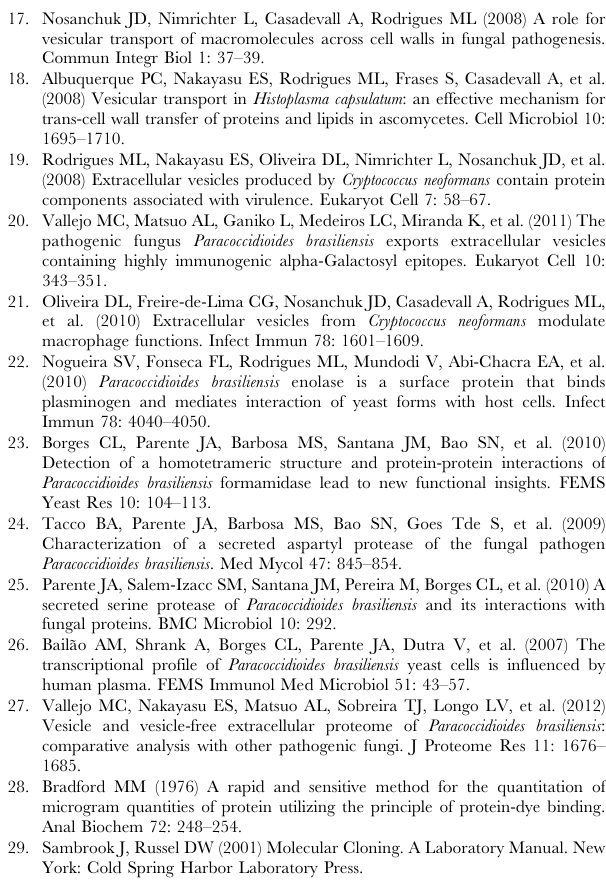
Table S3 Predicted post-translational modifications of identified protein isoforms in mycelia and yeast secre- tomes. 1 Protein Expression in M: mycelia phase; Y: Yeast phase and C: protein common or protein with no differential expression. 2 PTM – Post translational modifications: acetyl (k) – lysine acetylation; phospo (S-T-Y) – serine, threonine and tyrosine phosphorylation. 3 Values returned by MASCOT search tool using none or specific variable modifications.